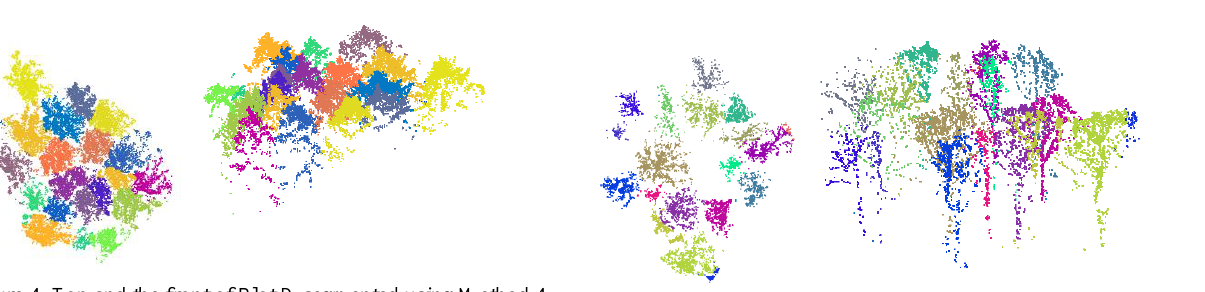
Figure 6. Top and the front of Plot A segmented using Method 5 (calibrated), with each separate tree assigned a random colour.